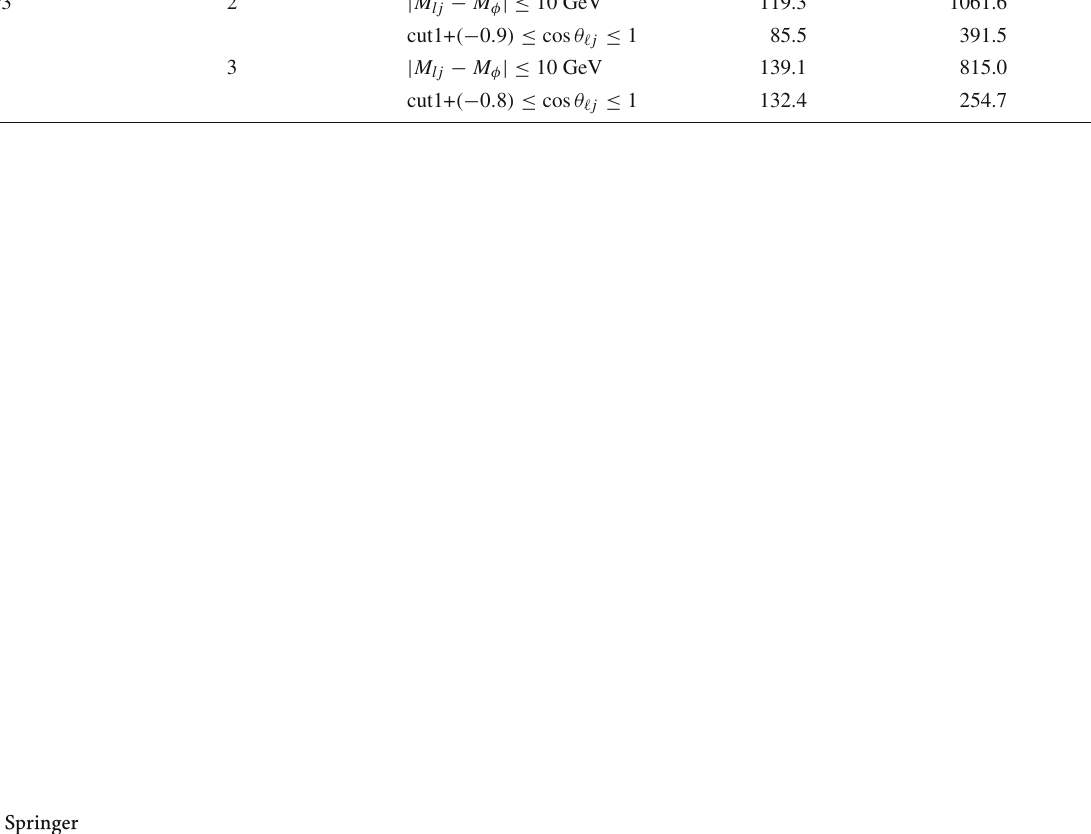
Table 11 Signal-background analysis for ( V + 4 Bench-mark